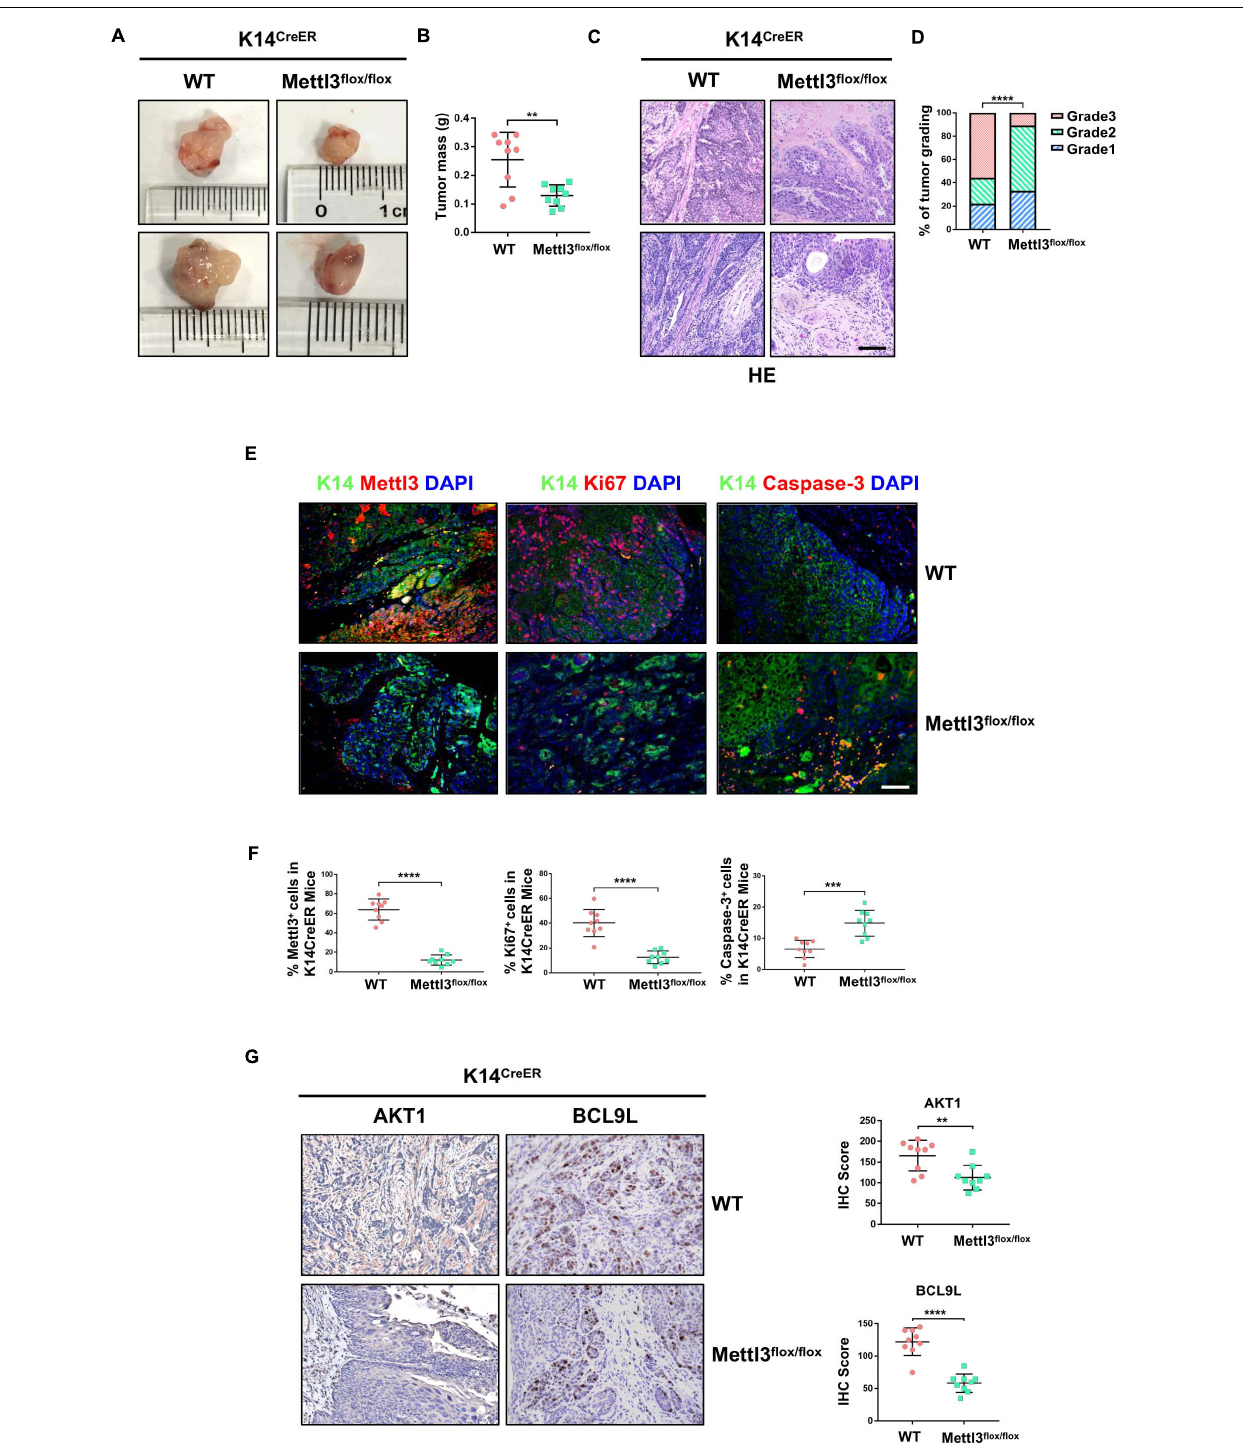
FIGURE 2 | Deletion of Mettl3 in K14 + cells displays reduced tumorigenicity, cell proliferation, and survival. (A) Representative images of bladder cancer (BCa) lesions from K14 CreER , Mettl3 wt / wt or K14 CreER , Mettl3 flox / flox mice. (B) The bladder weight was calculated in wild-type and Mettl3 flox / flox mice, respectively. (C) Representative H&E staining images of BCa section in wild-type and Mettl3 flox / flox mice show the histological atypia. Scale bars, 50 µ m. Scale bar, 100 µ m. (D) Assessment of malignancy in wild-type and Mettl3 flox / flox mice by tumor grading. (E) Immunofluorescent staining was used to evaluate the expression of K14, Mettl3 (left), Ki67 (middle), and Caspase-3 (right). 4 (cid:48) ,6-Diamidino-2-phenylindole (DAPI) staining was used to mark nucleus. Scale bar, 100 µ m. (F) Calculation of Mettl3 (left), Ki67 (middle), and Caspase-3 (right) positive cells in wild-type and K14 CreER , Mettl3 flox / flox mice. (G) Immunostaining and IHC score of AKT1 and BCL9L in K14CreER wild type and K14CreER KO mice